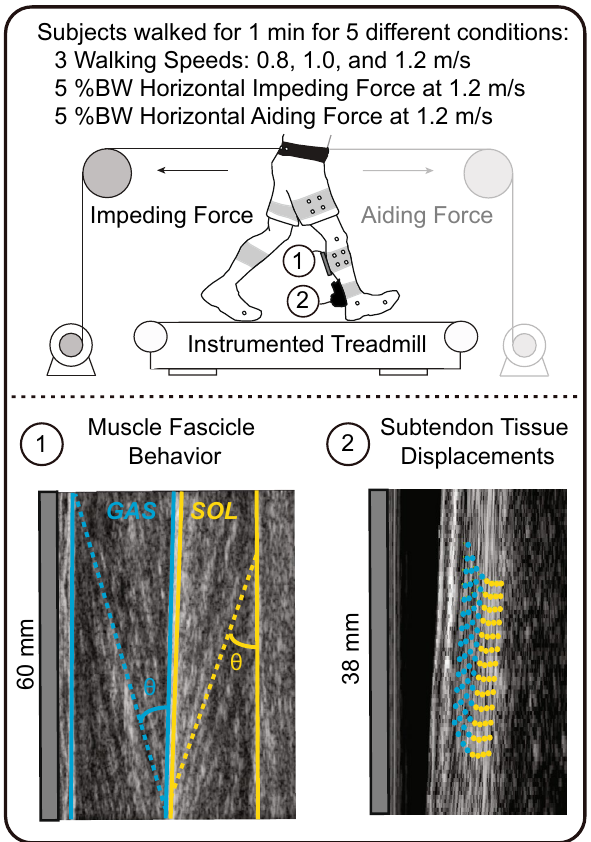
Figure 5. Schematic showing experimental manipulations and the application of dual-probe ultrasound imaging of (1) medial gastrocnemius (GAS-blue) and soleus (SOL-yellow) muscle contractile behavior and (2) Achilles subtendon tissue displacements. Figure in upper panel created using Adobe Illustrator (version 25.4.1, available from: https:// adobe. com/ produ cts/ illus